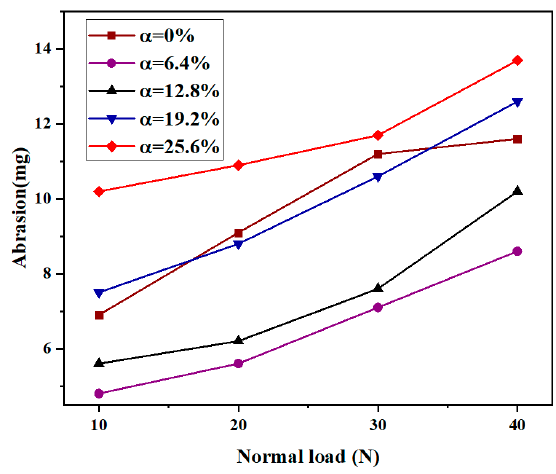
Figure 7. Variation of abrasion with normal load.